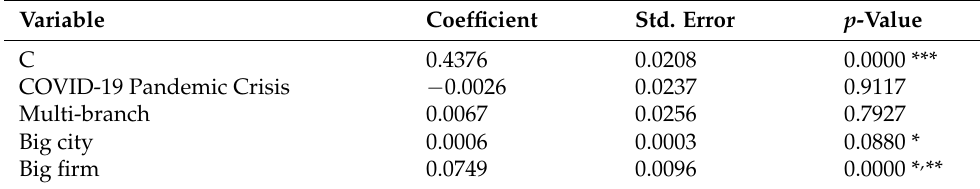
Table 10. The results of the tenth research model.